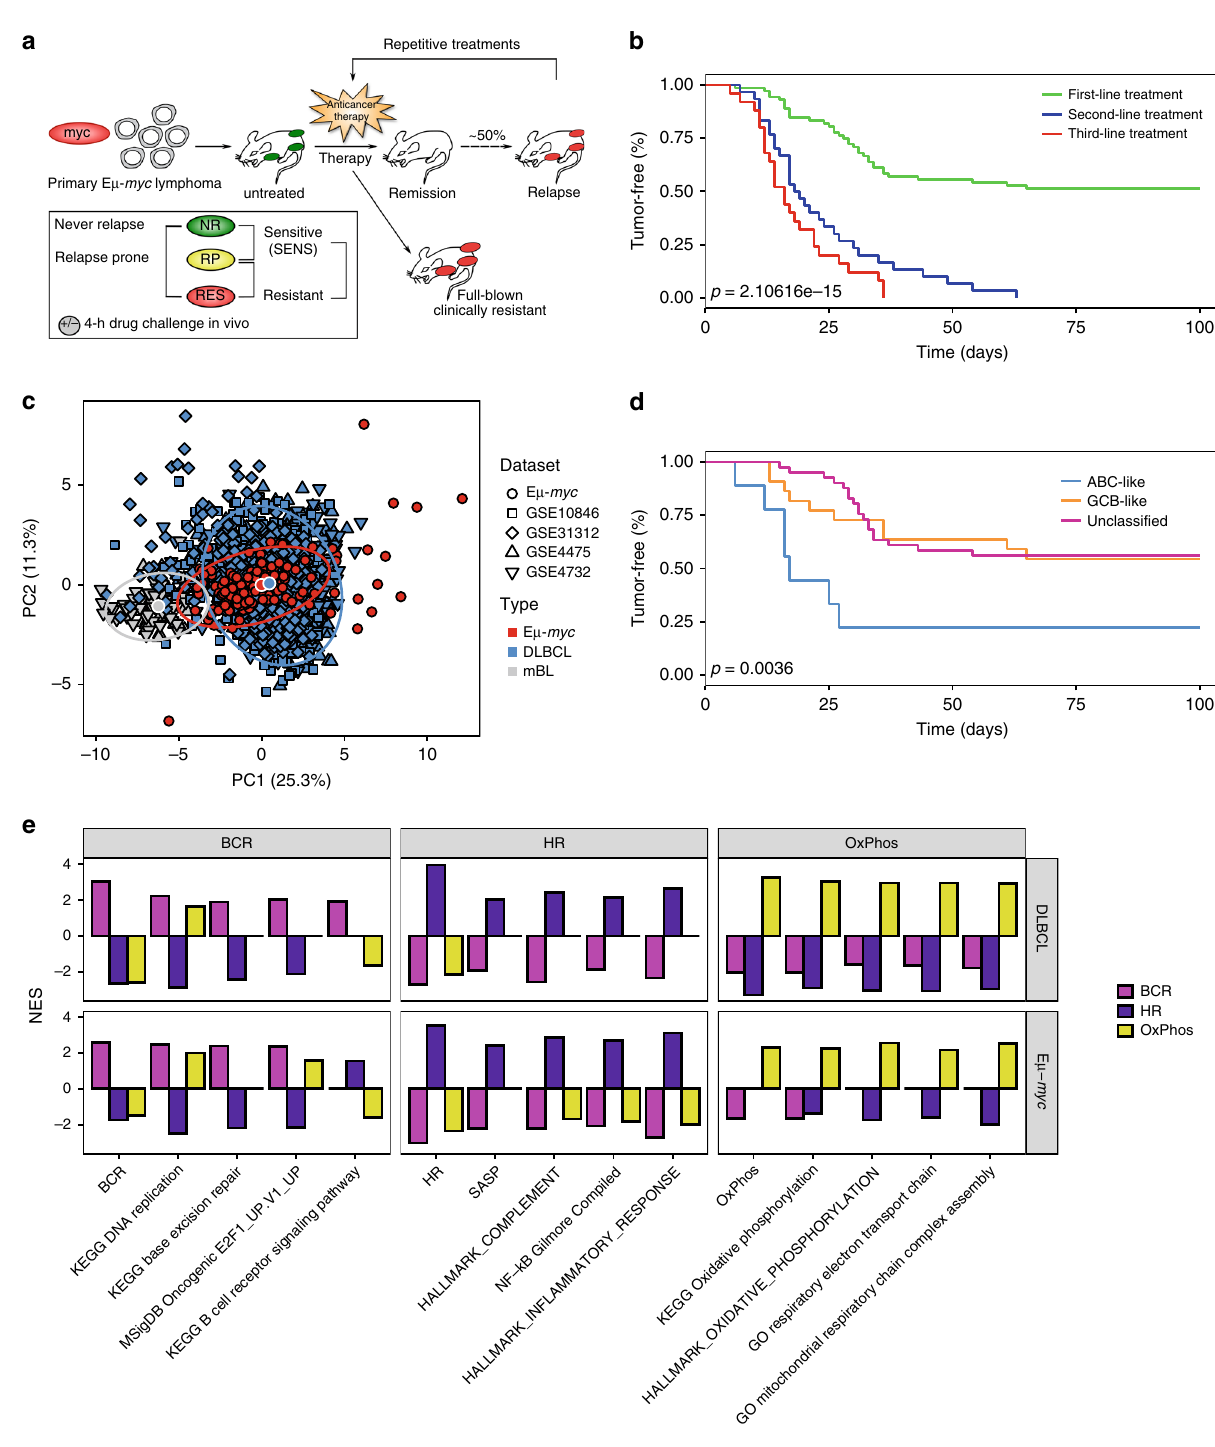
Fig. 1 The E µ - myc mouse lymphoma model recapitulates molecular signatures and some clinical features of human DLBCL. a Utilization of the E µ - myc model in a clinical trial-like fashion. E µ - myc lymphomas were transplanted into wild-type recipients and treated with CTX upon lymphoma formation. After initial remission, tumors that relapsed (RP, unlike those that did not [NR]) were retreated. Lymphomas were considered clinically resistant after a third relapse (RES). b Tumor-free survival of CTX-treated mice after fi rst(-line) treatment ( n = 76, green line), after second treatment ( n = 31, blue line), and after third treatment ( n = 28, red line). Two mice per lymphoma were monitored for response. c Principal components analysis based on signature genes separating patients with Burkitt ’ s lymphoma ( n = 98) from those with DLBCL ( n = 1305) in different datasets and E µ - myc lymphomas ( n = 154). Each dataset was separately row (gene) mean-centered and scaled to unit variance before being combined in a single dataset. The larger white-bordered points denote the centroid of each lymphoma type. d Tumor-free survival of CTX-treated mice bearing ABC-like ( n = 10), GCB-like ( n = 24) or unclassi fi ed ( n = 42) E µ - myc lymphomas. Two mice per lymphoma were used. e Pattern comparison of multiple GSEA results of the three distinct CCC subgroups (as indicated) with one compared against the two others for DLBCL cases and E µ - myc lymphomas. Each column shows group-speci fi c upregulated gene sets. The color code denotes analyses of each CCC group against the rest. NES normalized enrichment